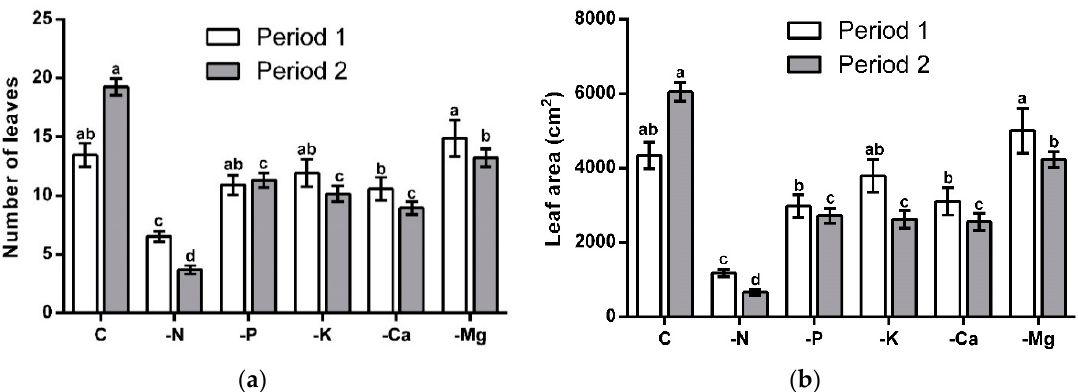
Figure 2. Effect of macronutrient deficiency on the number of leaves ( a ) and leaf area ( b ) in two periods. Different letters between the columns for each period indicate significant difference (Tukey, p < 0.05). The lines on the bars indicate the standard error of the mean. n = 4.